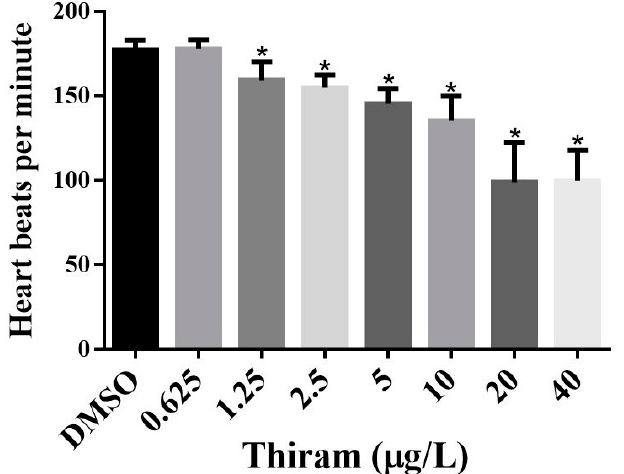
Figure 3. Average heartbeats per minute at designated concentrations of thiram. The heart beats were counted at 48 hpf. Data shown as mean ± SD were obtained from six plates (three independent experiments). Statistical differences were analyzed using an unpaired t -test; * p < 0.05.